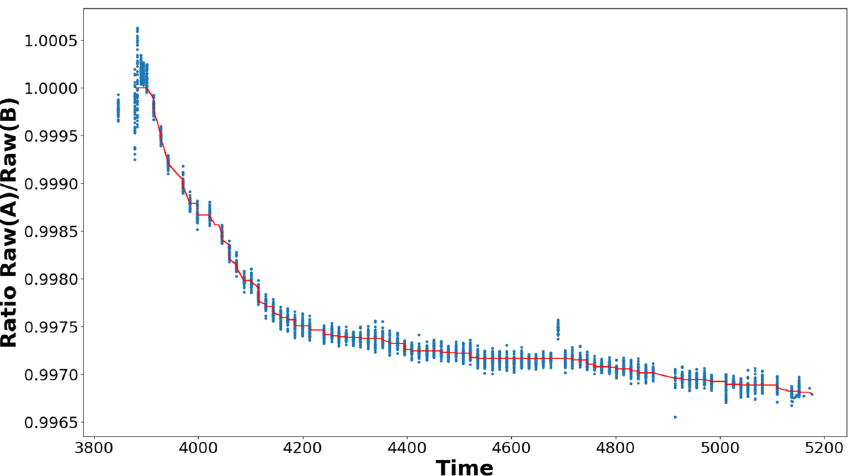
Figure 1. Ratio of the raw measurements PMO6-PA and PMO6-PB as a function of time (days since 1 January 2000). The red curve is the degradation correction function. Note that the early-increase was corrected manually before running the degradation correction algorithm. The degradation curve thus only starts after the early- increase phase of PMO6-PA (see text for details on the “early increase” phenomenon).